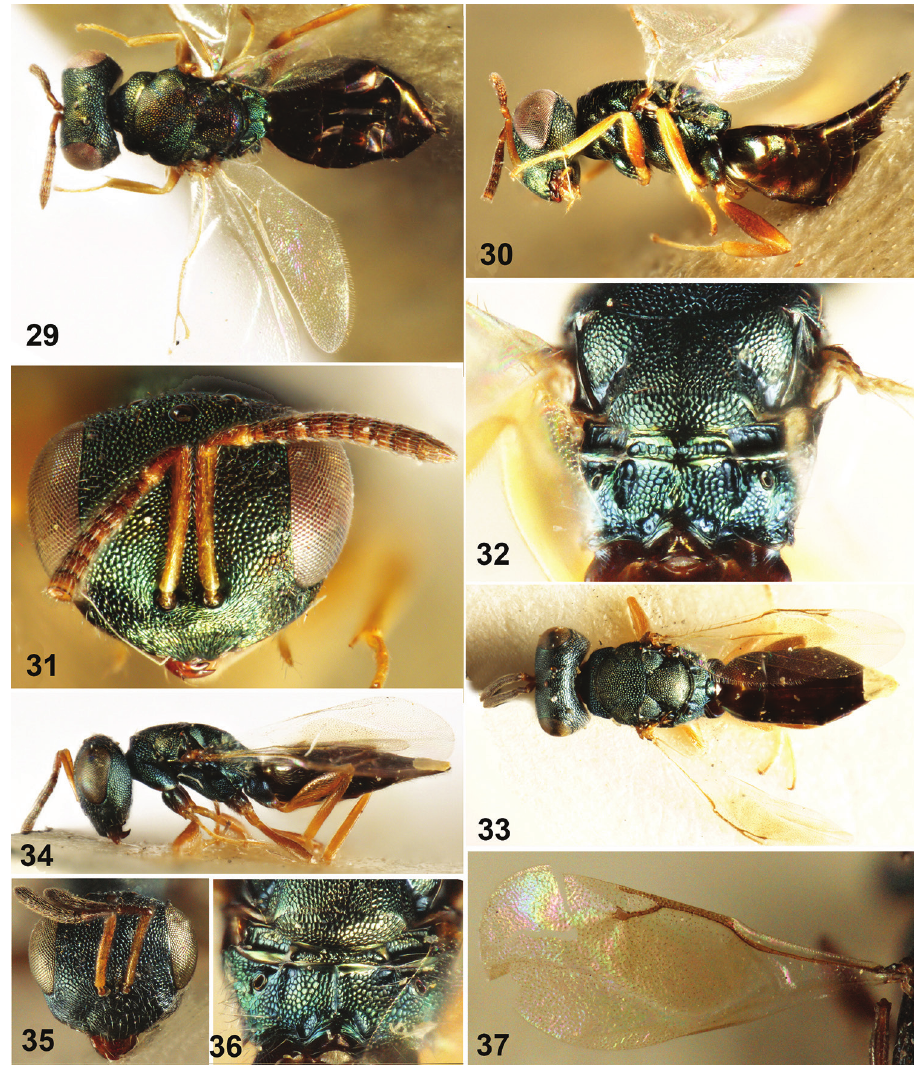
Figures 29–37. 29–32 Dibrachys liaoi sp. n., female holotype 29 Body in dorsal view 30 Body in lateral view 31 Head in frontal view 32 Propodeum 33–37 Dibrachys maculipennis Szelényi 33 Body in dorsal view 34 Body in lateral view 35 Head in frontal view 36 Propodeum 37 Fore wing. of anterior ocellus; length of pedicel and flagellum combined shorter than head width (0.84×); pedicel in lateral view 2.6× as long as broad; anelli transverse; Fu to Fu slightly 1 4 longer than broad respectively, Fu and Fu quadrate; each funicular segment with one 5 6 row of longitudinal sensilla; clava slightly clavate, 2.43× as long as broad, micropilosity only limited to apex of third clava segment. Head in dorsal view 1.89× as wide as long; vertex convex, occipital carina strong; eye length 2× temple length; POL 1.64×